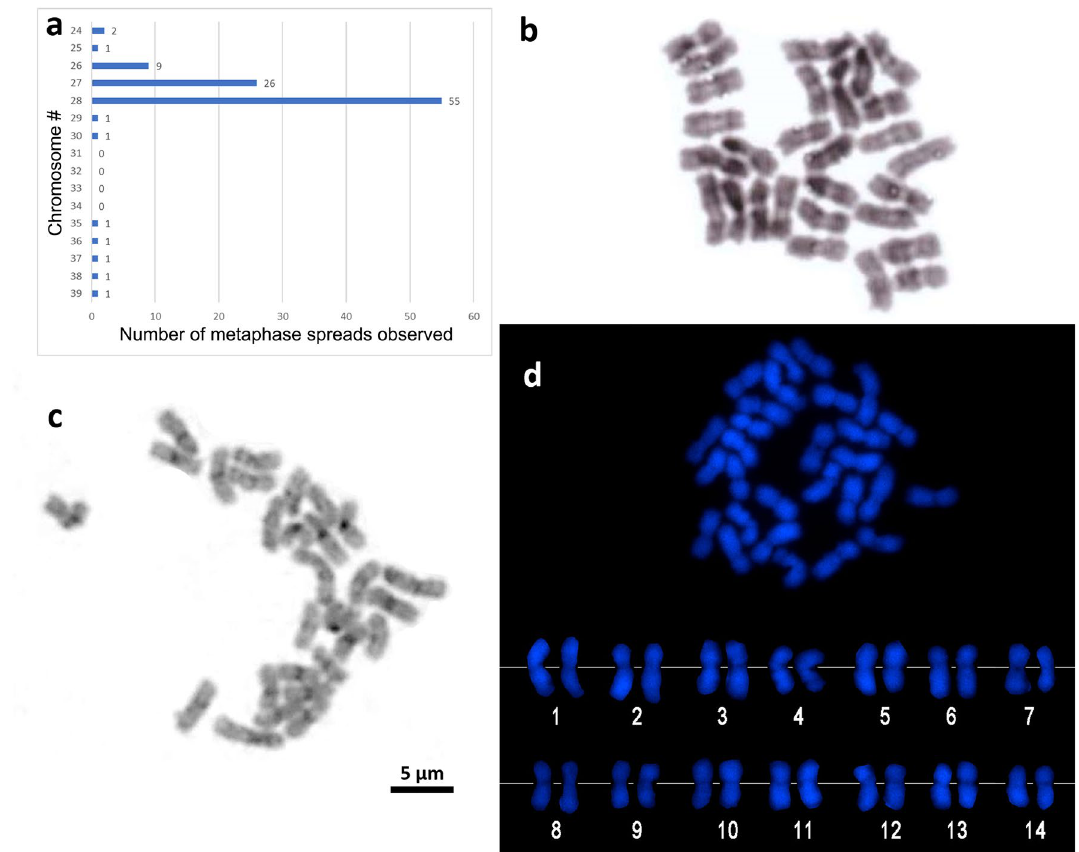
Figure 1. Chromosome numbers observed from 100 metaphase spreads ( a ). Acropora pruinosa chromosomes visualized by Giemsa staining ( b ) and C-banding ( c ). DAPI staining showing distinct centromeres ( d